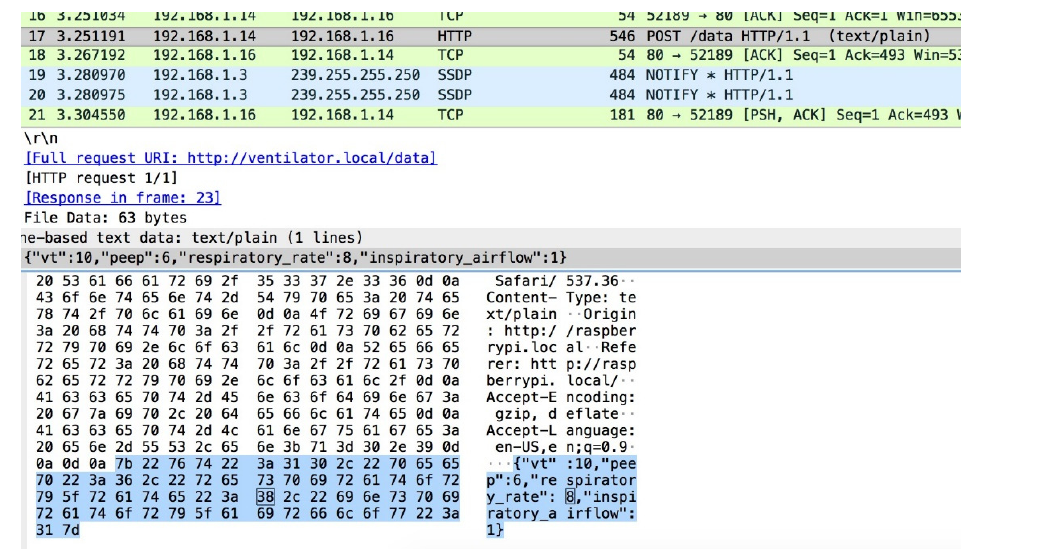
Figure 12. Capture adversarial sensor values under attack scenario.